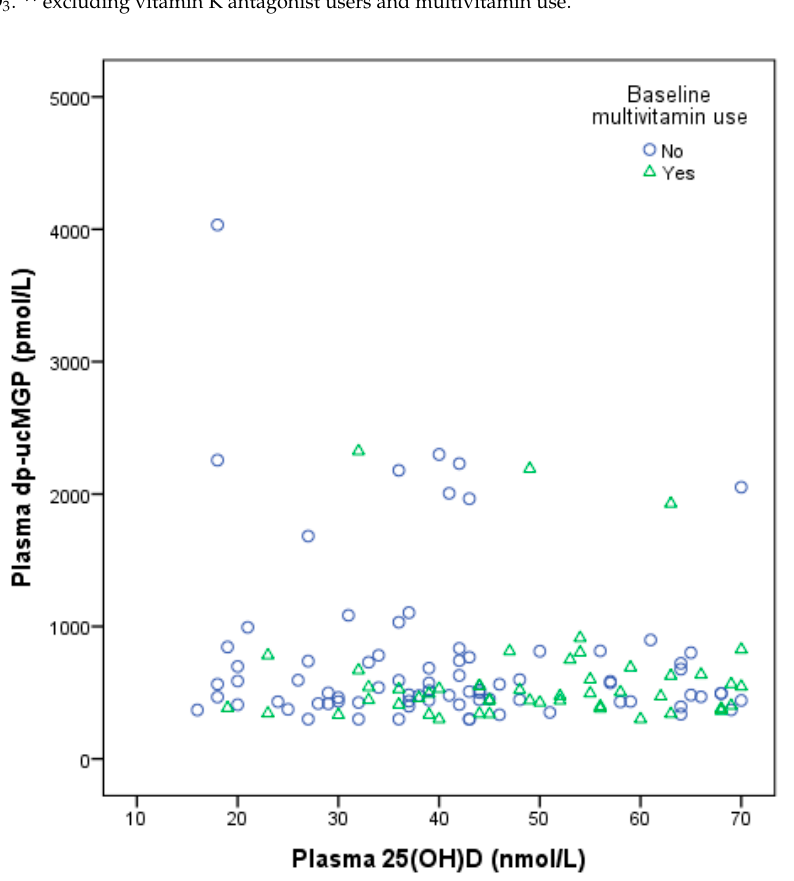
Values represent number and percentages or mean and standard deviation. * Vitamin D use by